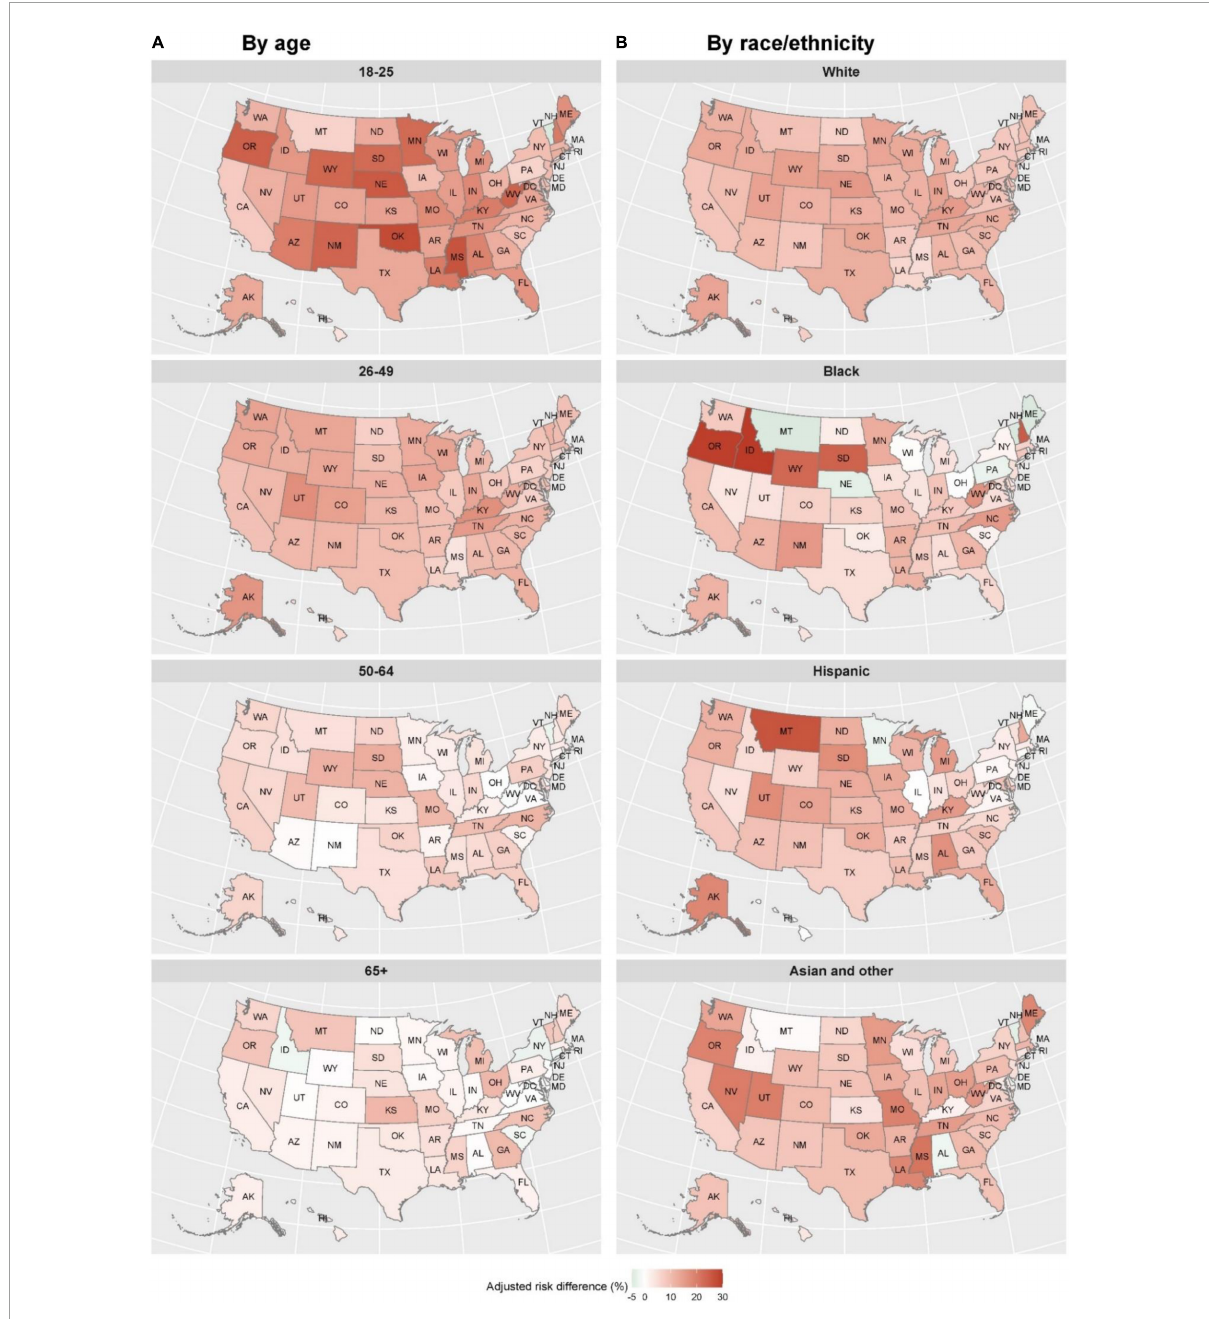
FIGURE2 Geographic variation in the difference in unmet mental health needs between LGBTQ+ and non-LGBTQ+ (as reference) by states, age, and race/ethnicity, from 21 July 2021 to 9 May 2022. Color presents the values of adjusted risk differences. In (A) , the results were extracted from multivariable logistic regression models for each age group, with LGBTQ+ status (yes vs. no) as the key predictor, controlling for other covariates. In (B) , the results were extracted from multivariable logistic regression models for each race/ethnicity, with LGBTQ+ status (yes vs. no) as the key predictor, controlling for other